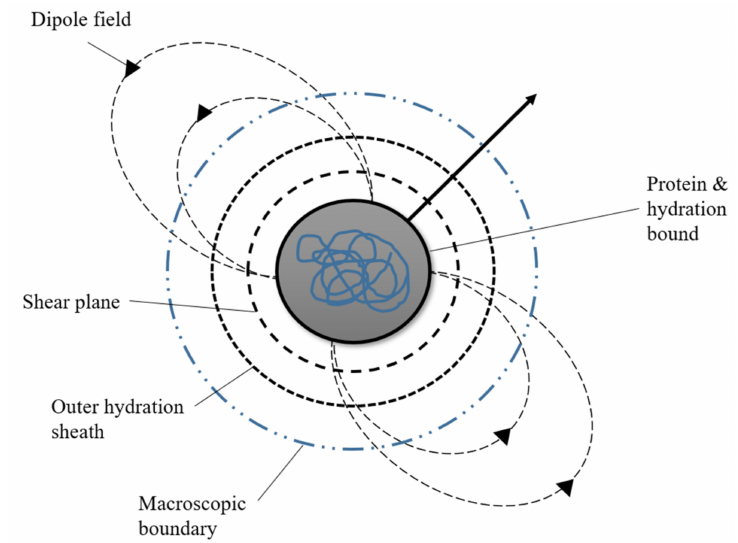
Figure 4. ‘Russian doll’ model of a protein. The protein is surrounded by a permanent dipole moment. The protein fills the most internal cavity which is strongly attached to water molecules.